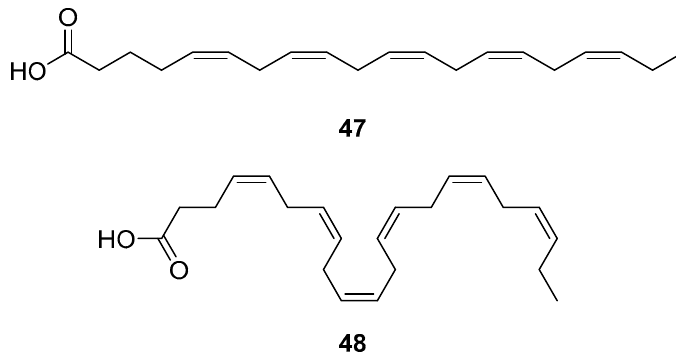
Figure 21. Structures of eicosapentanoic ( 47 ) and docosahexanoic acid ( 48 ).